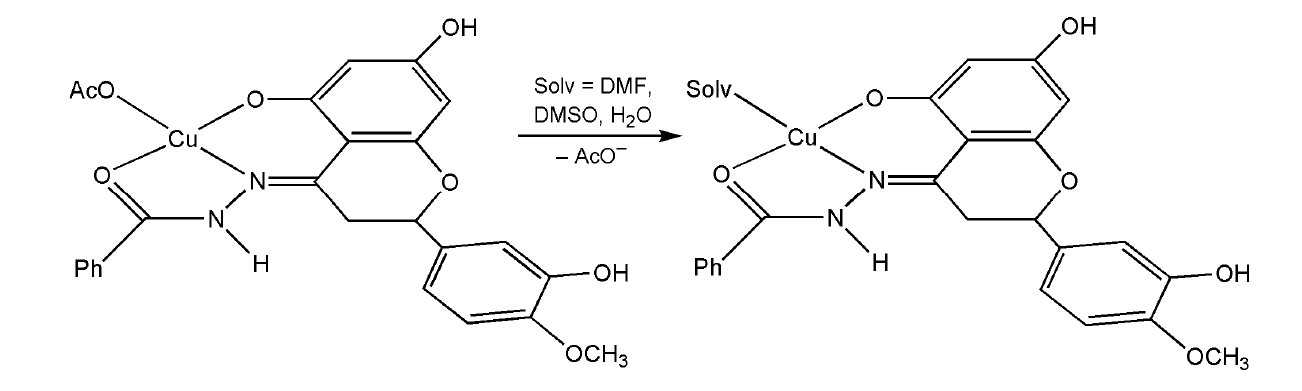
Table 1. Spin Hamiltonian parameters of copper(II) complexes formed by HHSB and HTSC. Species g z A z /10 − 4 cm − 1 ∆ H/mT a Coordination Mode